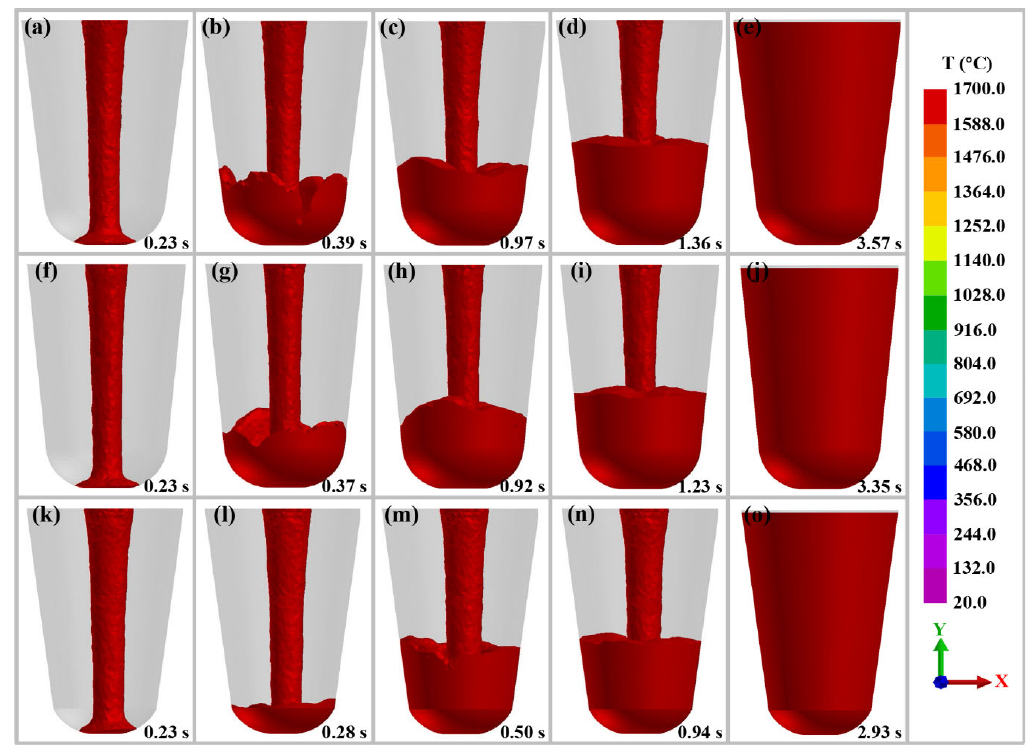
Metals 2022 , 12 , 2122 Figure 4. Filling process of Ti ‐ 6Al ‐ 4V alloy in mold II ( a – e ), III ( f – j ), and IV ( k – o ). Figure 4. Filling process of Ti-6Al-4V alloy in mold II ( a – e ), III ( f – j ), and IV ( k – o ).